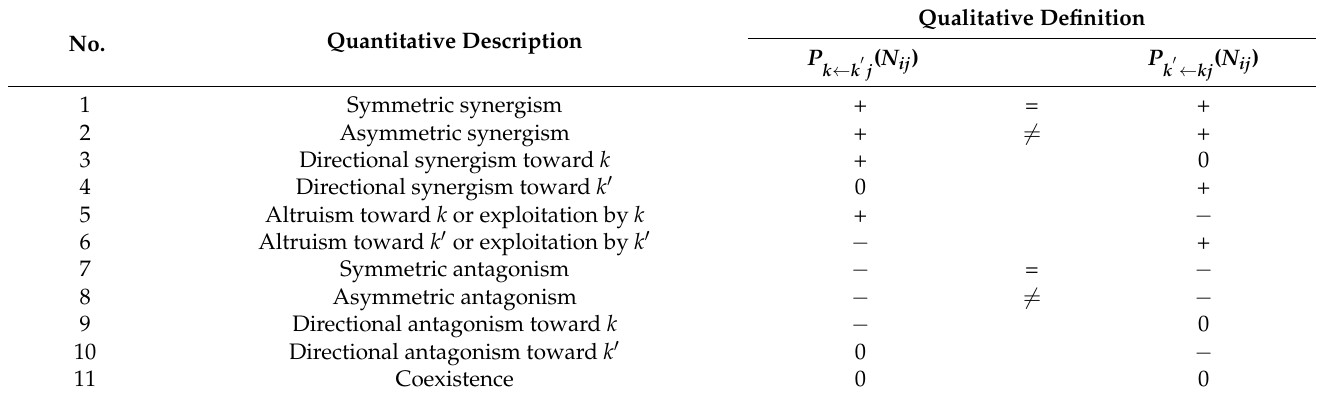
Table 1. Qualitative class of FGC–soma interaction and its quantitative characterization by the qdODE game